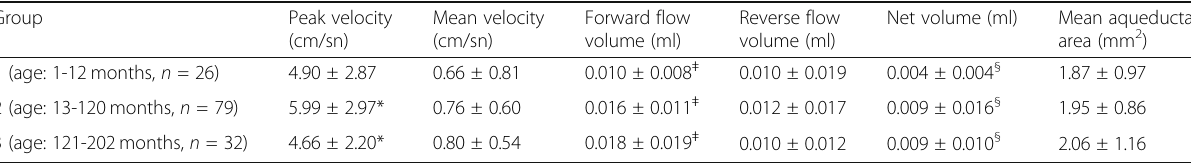
Table 2 Phase contrast MRI parameters in various age groups Group